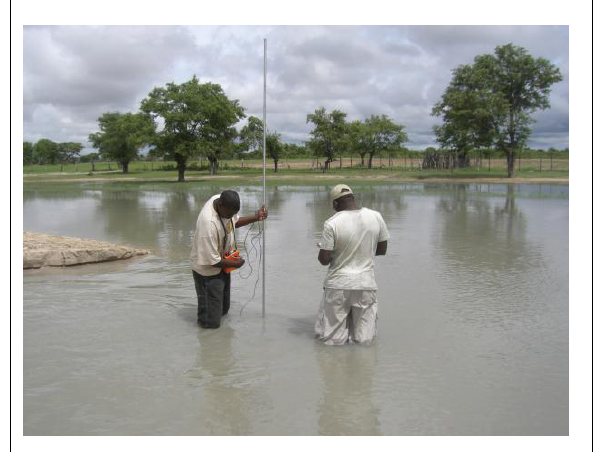
Figure 2. Hydrologists in Namibia validating flood water depth and river flow rates against satellite data, courtesy of